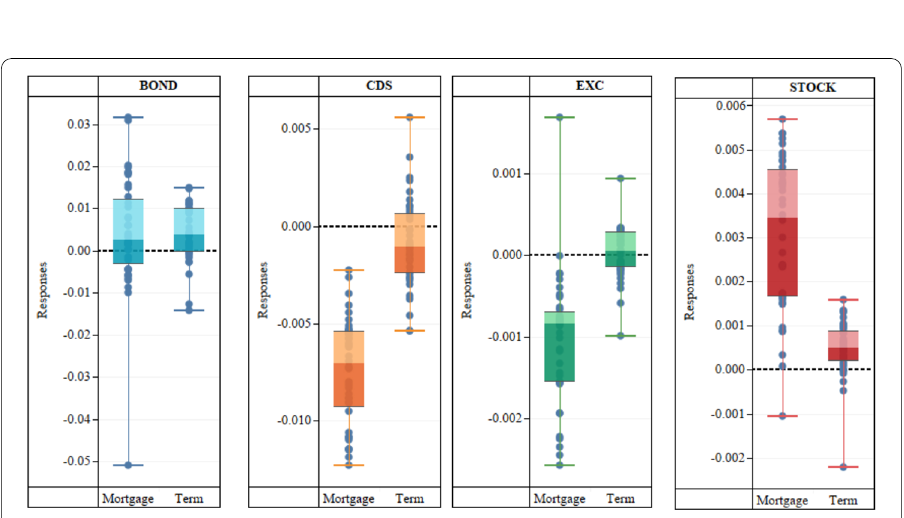
Fig. 9 Distribution of immediate responses to US mortgage and term spread